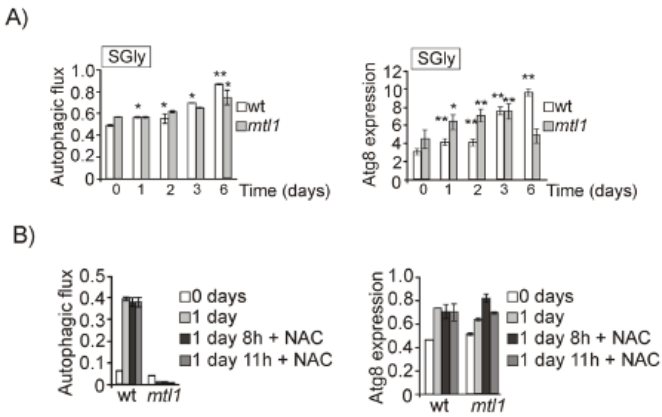
Figure 7. Mtl1 is not deficient in bulk autophagy in respiratory conditions. ( A ) wt and mtl1 cultures were grown in minimum medium SGly (containing glycerol as unique carbon source) plus amino acids at 30 °C to stationary phase for 6 days. Samples were collected at the indicated times to identify macroautophagy as described in Figure 1B. ( B ) wt and mtl1 cultures in SD medium growing to 1 day were treated with N-Acetyl cysteine (NAC) 5 mM for 8 and 11 h. Samples were collected for autophagy determinations as in ( A ). Error bars in the histograms represent the standard deviation (SD) calculated from three independent experiments. Significance of the data was determinate by p -values from a Student’s unpaired t -test denoted as follows: * = 0.05 > p > 0.01; ** = 0.01 > p >